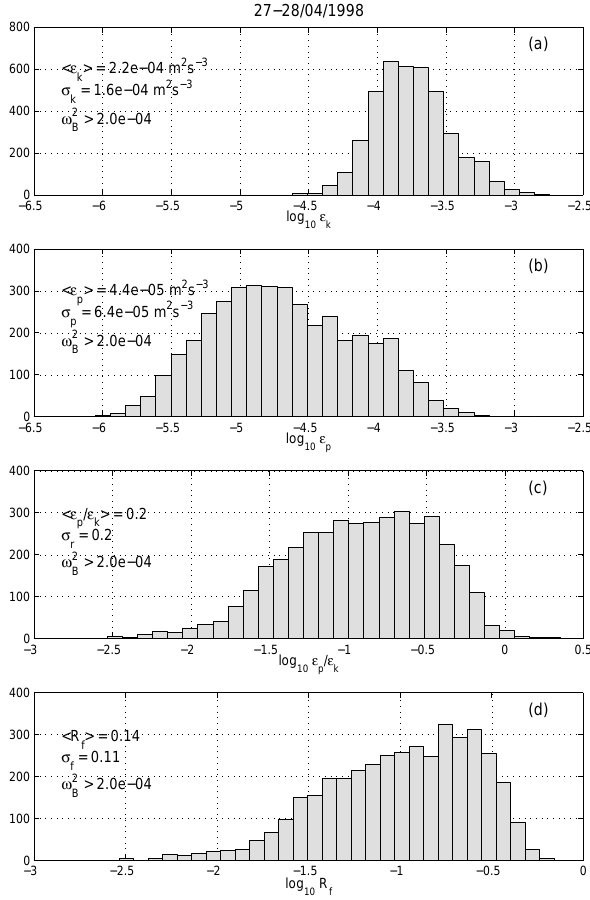
Fig. 5. Simultaneous temperature profiles obtained by the SFT (red) and V¨ais¨al¨a (blue) sensors. The shaded profile shows the C 2 n esti- mated from the SFT data.